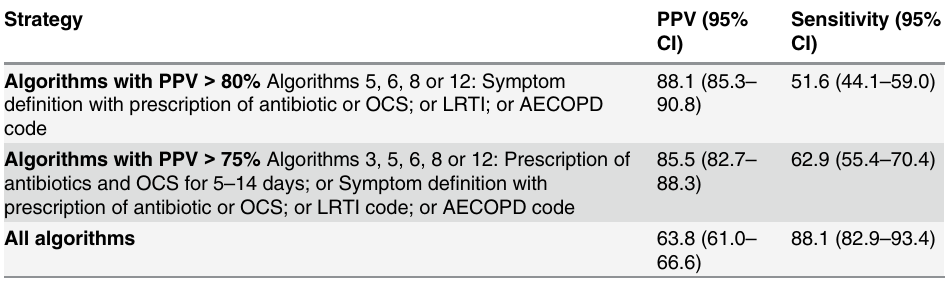
Table 6. PPV and sensitivity of composite strategies to identify AECOPD including only patients for whom additional information was available from their GP questionnaire. Strategy PPV (95%